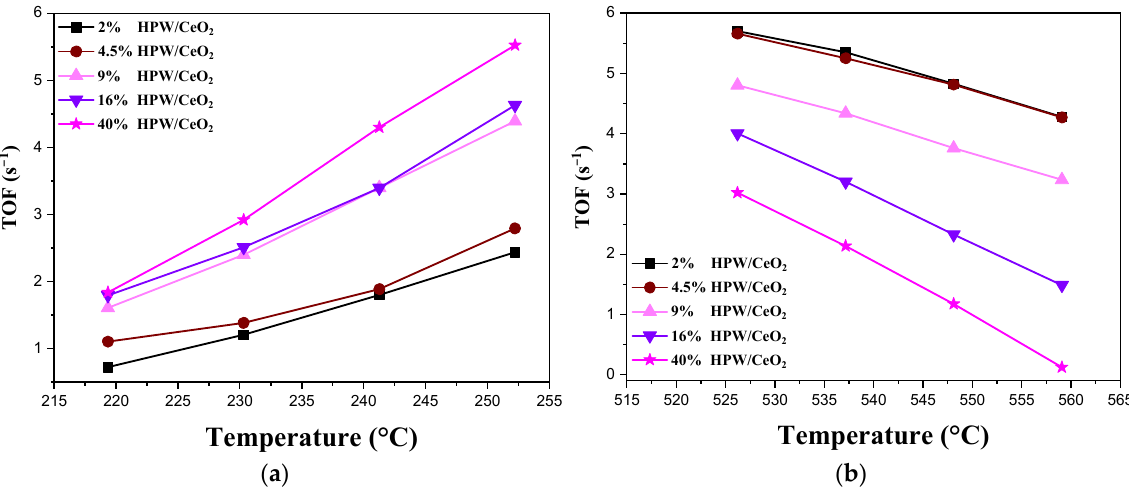
Figure 7. TOF of HPW/CeO 2 (2, 4.5, 9, 16, and 40%wt W) at low ( a ) and high temperatures ( b ).